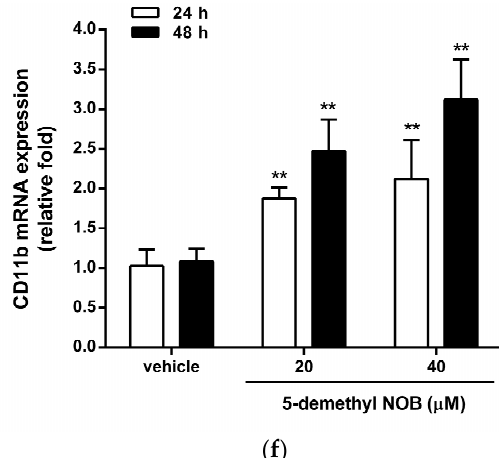
Figure 3. Effects of 5-demethyl NOB on cell apoptosis and differentiation. THP-1 cells were treated with vehicle or 5-demethyl NOB (20 and 40 μ M) for 48 h, and cell apoptosis was detected by flow cytometric analysis. ( a ) A representative histogram of cell apoptosis. ( b ) The percentage of apoptotic cells was quantified. ( c – e ) Western blot analysis of apoptosis-related gene expression after 5-demethyl NOB treatment for 48 h. ( f ) THP-1 cells were treated with vehicle or 5-demethyl NOB (20 and 40 μ M) for 24 h and 48 h. CD11b mRNA expression was measured by RT–qPCR analysis. The data represent the mean ± SD of three independent experiments. ** p < 0.01 represents significant differences compared to the vehicle-treated group.